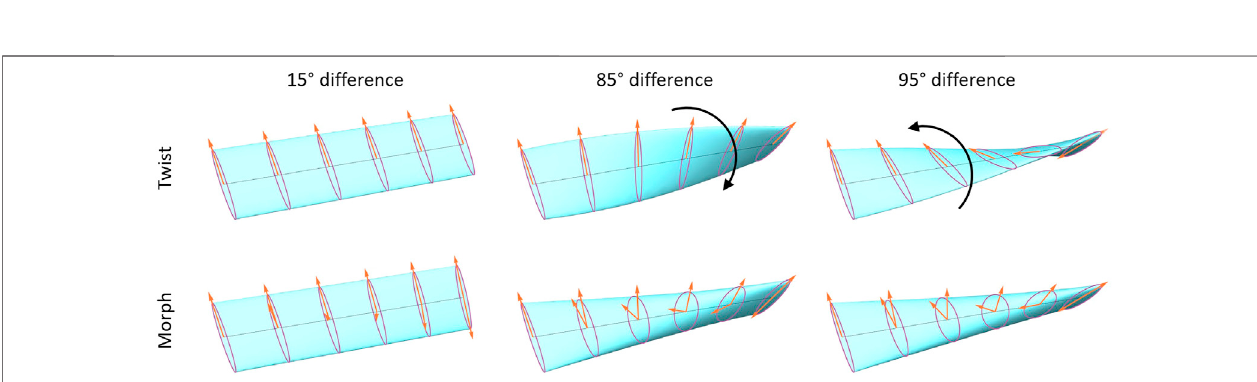
FIGURE2| Comparisonofthreedifferentmethodsofassigningacoordinateframetoeachpointalongacubiccurve (Fromlefttoright) TheFrenet-Serretframe, de fi nedintermsofthegeometryofthecurve(Willmore(2000));Therotationallyminimizedframe,generatedusingthedoublere fl ectionmethodofWangetal.(2008);and our method, using an average of the start and end binormals. Axes shown are the tangent (red), normal (blue) and binormal (green).